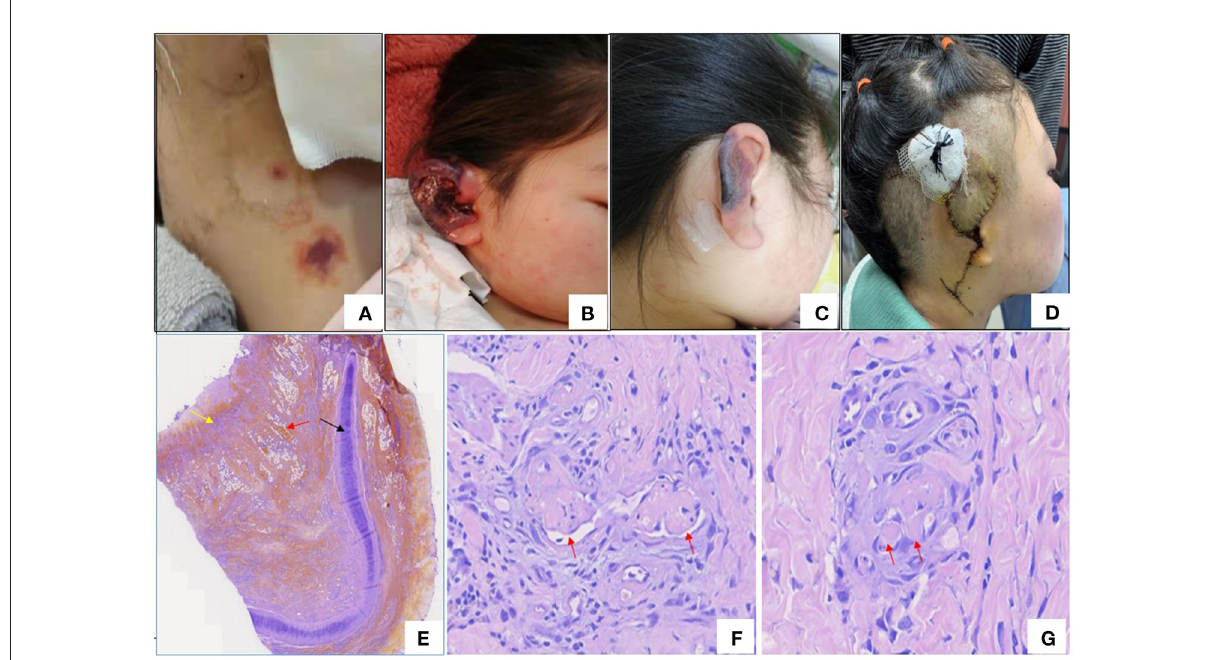
FIGURE1 (A) Rash in neck. (B) Congestion and edema of right auricle. (C) Necrosis of right auricle. (D) Right auricle excision and flap transplantation. (E) Histopathology of right ear (Hematoxylin –Eosin staining × 40), black arrow: cartilage, yellow arrow: necrosis and red arrow: necrosis and red arrow: hemorrhage. (F,G) The histopathologic examination of skin of right ear revealed microthrombi in small vessel (red arrows) (Hematoxylin-Eosin staining).